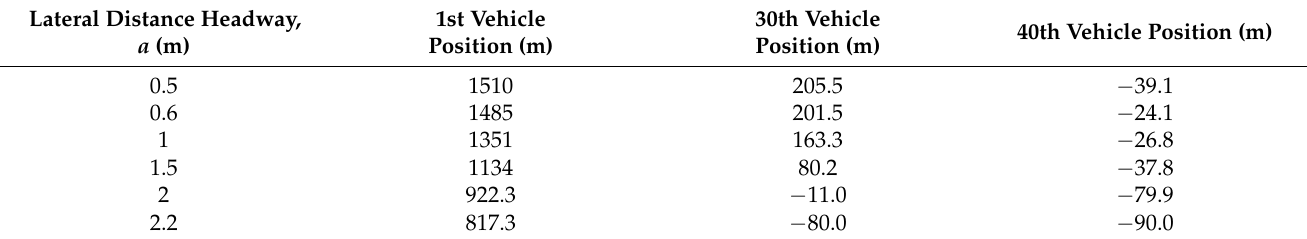
Table 8. Positions of the 1st, 30th, and 40th vehicles at 60 s for the proposed model. Lateral Distance